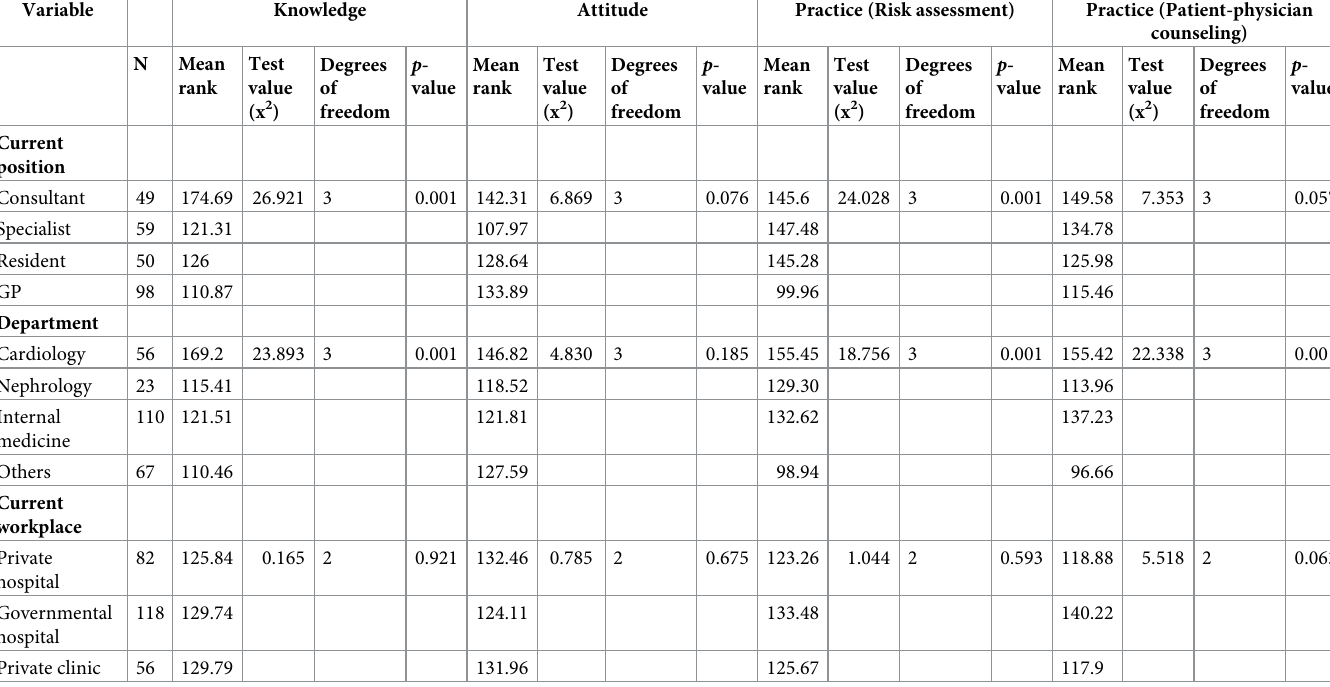
Table 5. The data for the Kruskal-Wallis test for the association between demographic variables (with more than two categories) and physicians’ knowledge, atti- tude, and practices of cardiovascular disease risk assessment. Variable